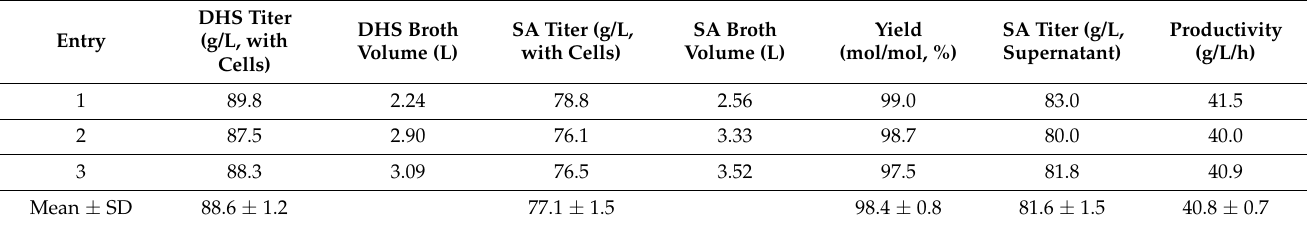
Table 1. The titer and yield of SA from DHS by RSF-serA biocatalyst after 2 h of whole-cell biocataly- sis.